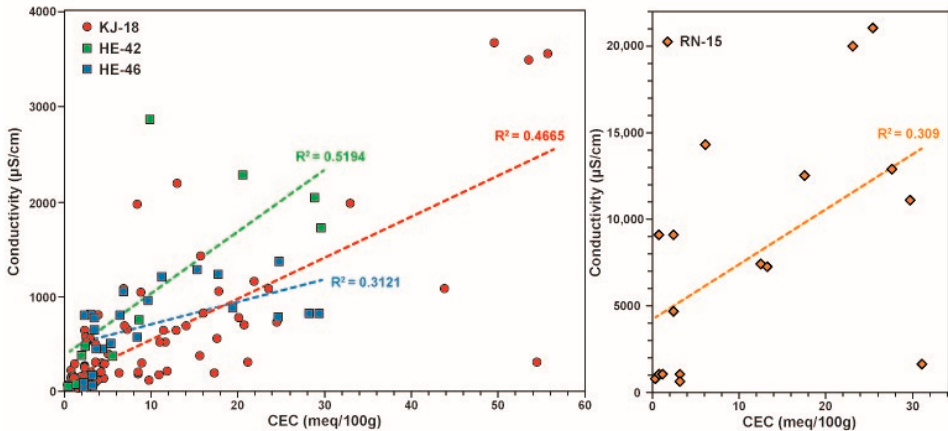
Figure 4. Correlation of the measured CEC and conductivity at similar given depth and corresponding trend lines. The left graph shows data from wells that are located within meteoric systems. The right graph shows the data from a well within the Reykjanes seawater-dominated geothermal system.